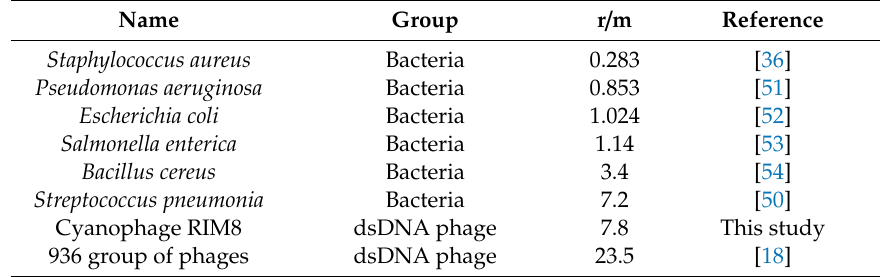
Table2. Typicalestimatesofr / mfromtheliterature. Thetableisrestrictedtogenome-wider /